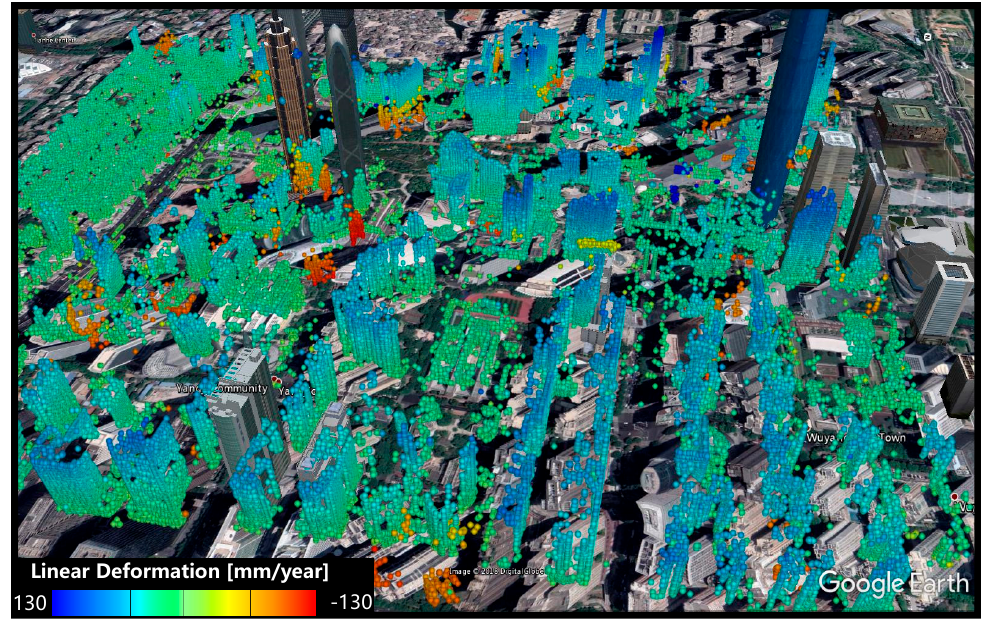
Figure 9. 3D-view of the estimated linear deformation trends visualized with Google Earth for the standard processing method.